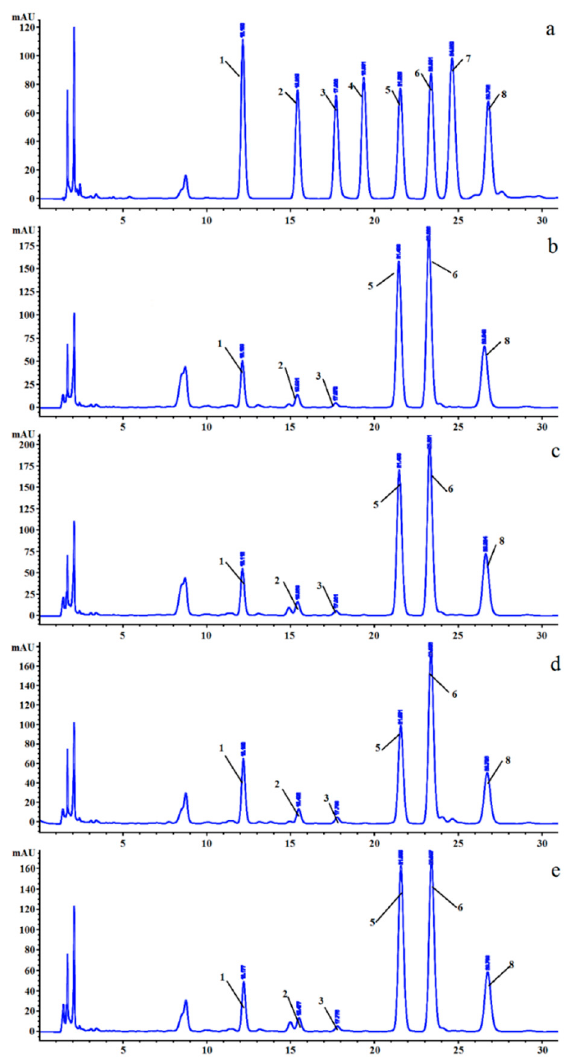
Figure 2. HPLC chromatograms of monosaccharide compositions of mixed standards and LVPs extracted by di ff erent methods: ( a ) mixed standards; ( b ) LVP-u; ( c ) LVP-m; ( d ) LVP-e; ( e ) LVP-h. The peaks identified are (1) mannose, (2) rhamnose, (3) galacturonic acid, (4) glucuronic acid, (5) glucose, (6) galactose, (7) arabinose, and (8) fucose.